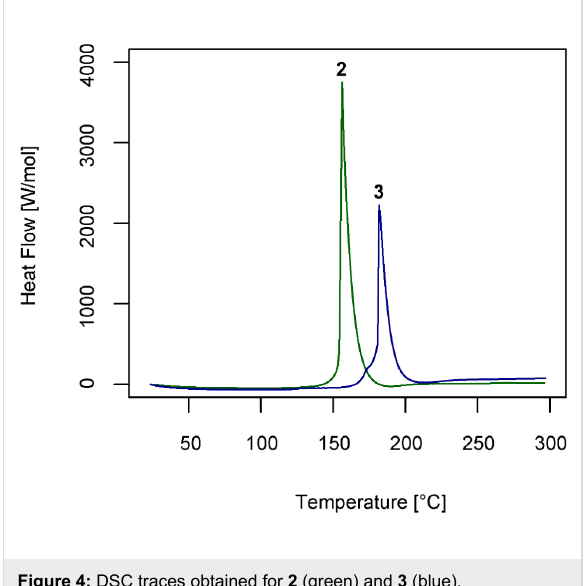
Figure 4: DSC traces obtained for 2 (green) and 3 (blue).